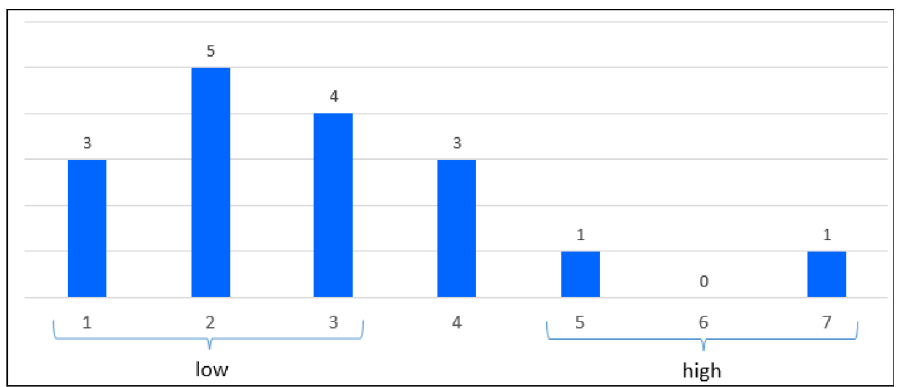
Figure 2. Employees’